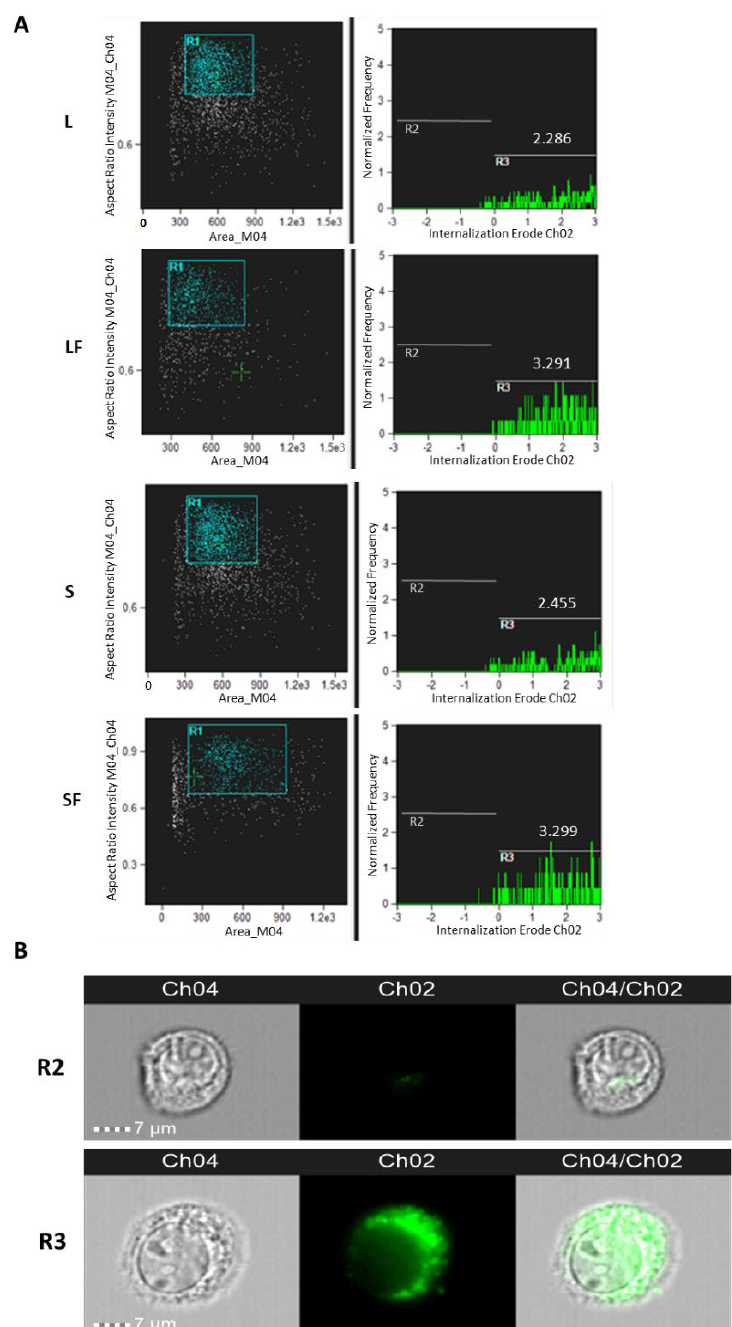
Figure 8. NP internalization analysis in T98G astrocytoma cells. ( A ) Amnis ImageStream flow cytometry analysis of NPs (i.e., L, LF, S, SF) internalization in T98G cells analyzed after 24 h p.t. Trypsinized cells were analyzed for the bright field (Ch04) and for BBR fluorescence (Ch02) at 60× magnification. Percentages of focused cells ( n = 2000) with BBR internalization spots and Internalization Erode median parameters are reported. NPs’ internalization was analyzed by “Internalization” wizard with the following gating strategy: single cells were gated (using Area/Aspect Ratio Intensity, R1); Ch2 intensity was measured with “Internalization” feature and an “Erode” mask applied (gates R2 and R3). Internalization scores for R3 gated cells are reported. ( B ) Examples of cell images of R2 and R3 gates are